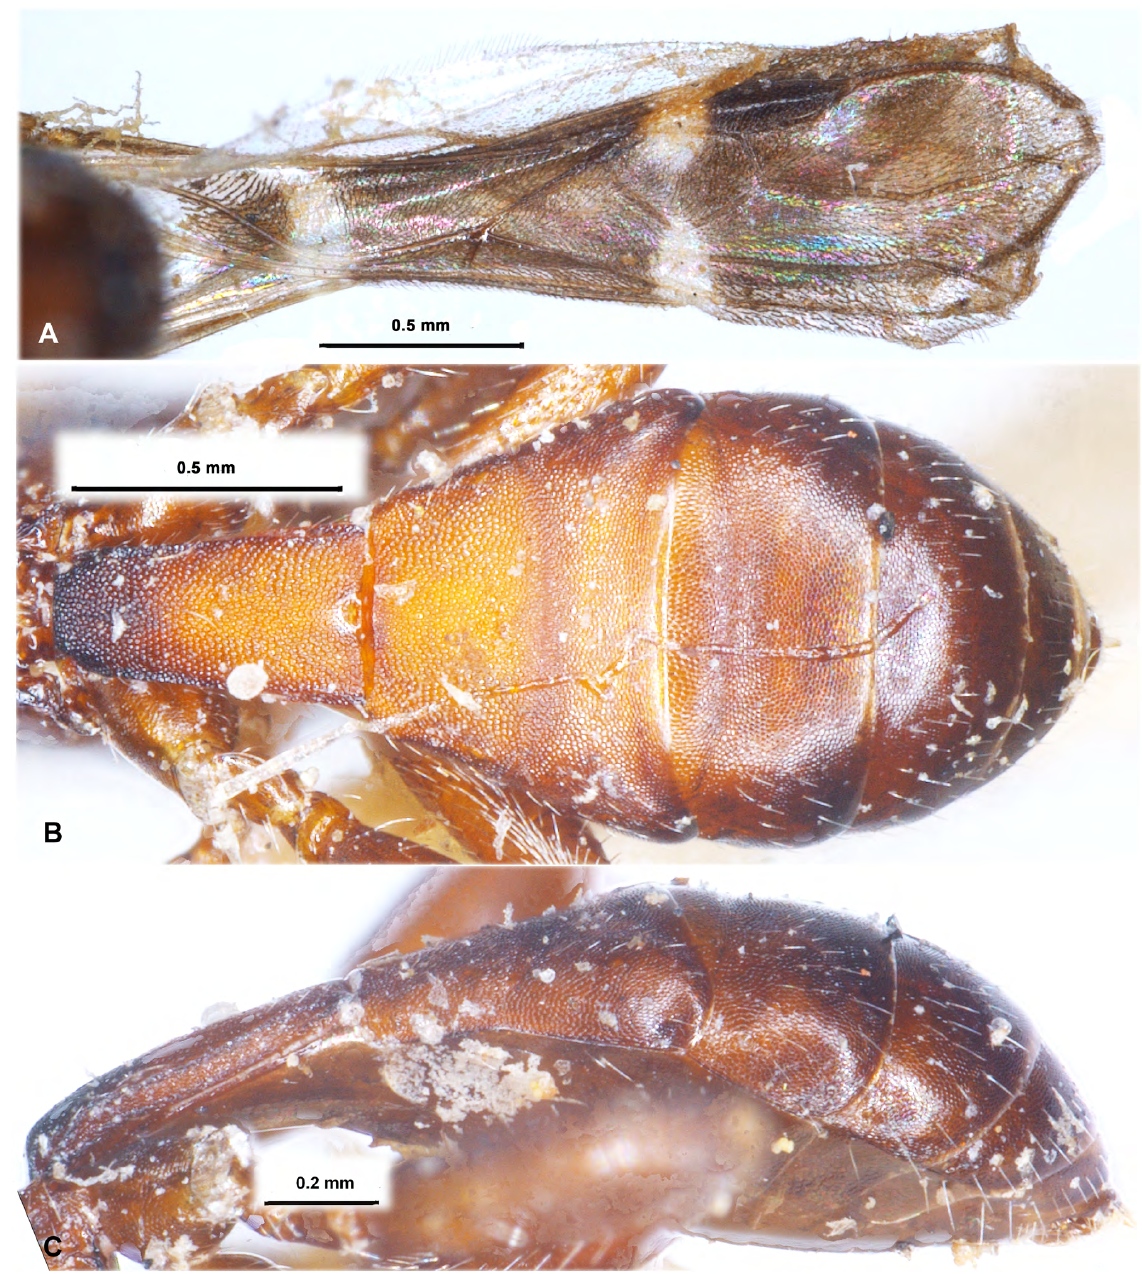
Fig. 29. Platyspathius ( Platyspathius ) pictipennis Viereck, 1911, ♂, holotype, USNM. A . Wings. B . Metasoma, dorsal view. C . Metasoma, lateral